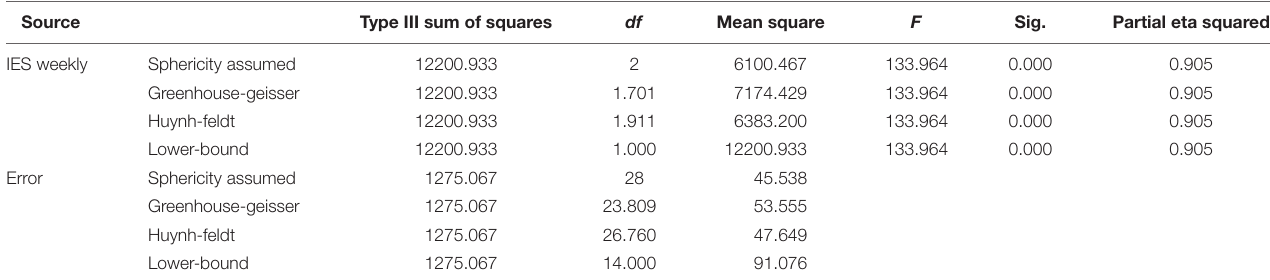
TABLE 5 | Tests of Within-Subjects Effects for the Weekly treatment group.